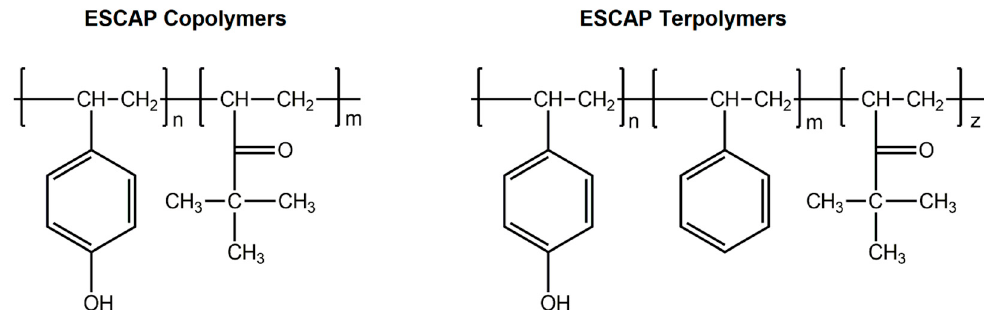
Figure 5. Polymers based on the environmentally stable chemical amplification photoresist (ESCAP) approach that are discussed in EUV resist formulations in ref [43]. The copolymer ( left ) consisted of poly(p-hydroxy styrene)-r-poly(t-butyl acrylate), the terpolymer ( right ) consisted of poly(p-hydroxy styrene)-r-poly(styrene)-r-poly(t-butyl